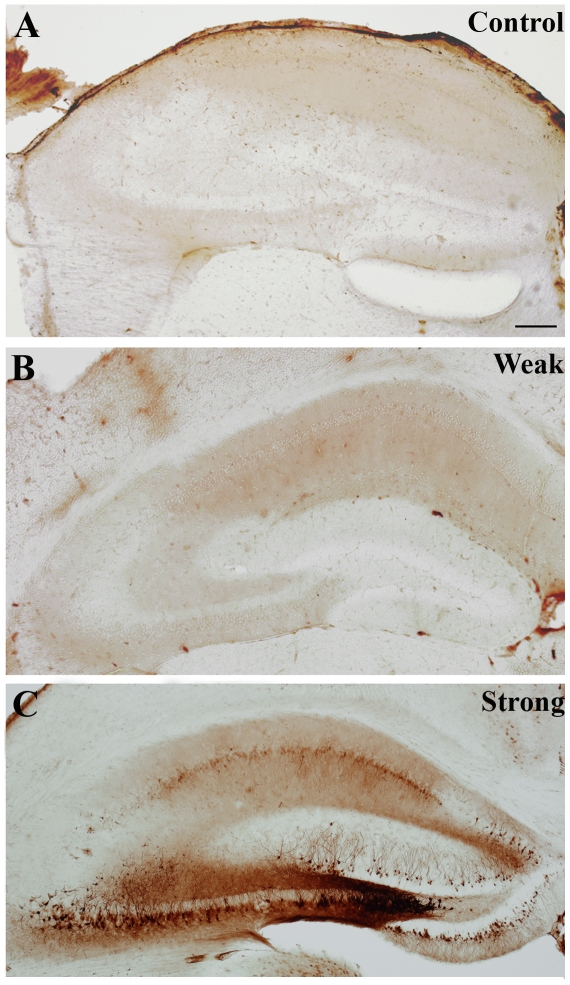
Demonstration of excitotoxic insult 1 day after pilocarpine treatment.In animals of the “weak” group (B) HSP72-immunostaining is control-like (A), only a slight increase in background-staining can be seen, but no stained cells with processes appear. Although there are no morphological signs of neuronal degeneration at this early stage in the hippocampi of “strong” epileptic animals (C) either, the vulnerable cells as well as the resistant granule cells start to express HSP72, and are stained in a Golgi-like manner. Faint homogeneous staining of CA1 pyramidal cells can also be seen. Scale: 200 µm.